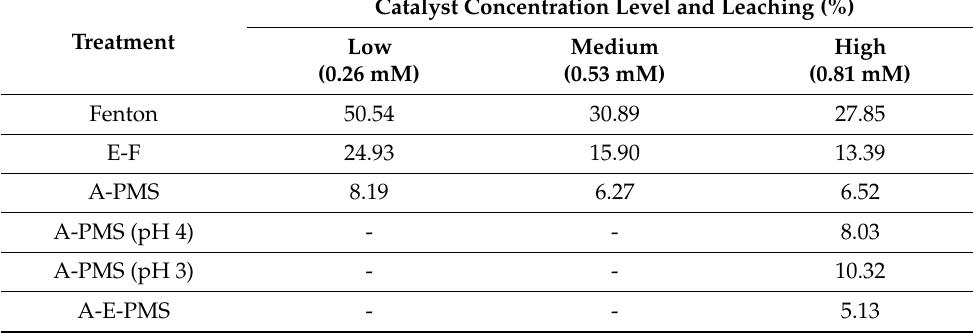
Table 1. Leaching iron values in the Fenton, E-F, A-PMS and A-E-PMS treatments. Catalyst Concentration Level and Leaching Treatment